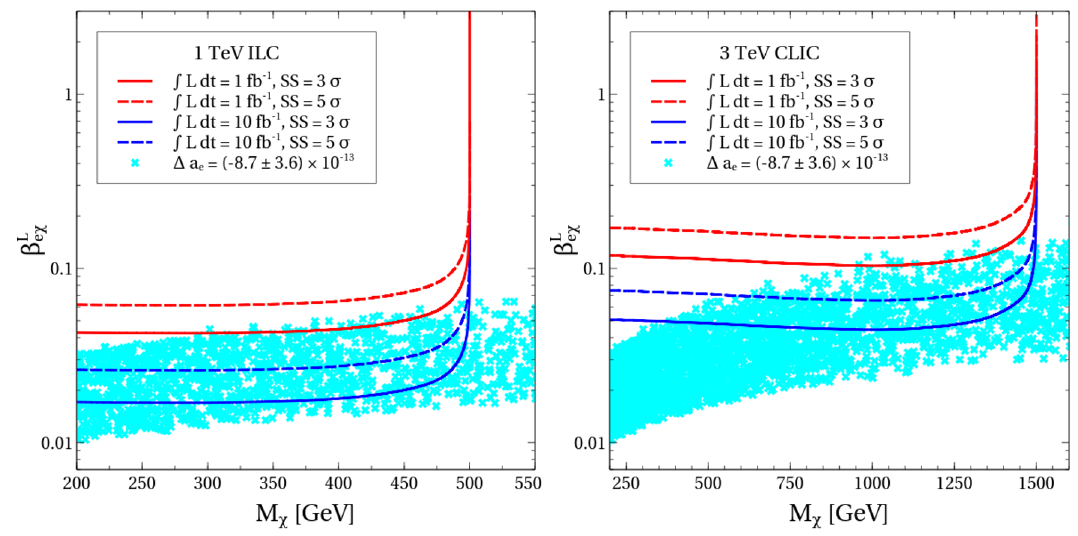
Figure 15 . Left and right panels show the allowed regions (by cyan colour points) after satisfying the ( g − 2) in β L − M χ plane for 1 TeV and 3 TeV lepton colliders, respectively. The solid and e eχ dashed lines correspond to the variation of 3 σ and 5 σ statistical significance lines of e + e − (cid:0) E signal T with the charged singlet fermion mass for the luminosity 1 fb − 1 and 10 fb − 1 , respectively. The other parameters kept fixed at β R = β L , M = 100 MeV, θ = 0 . 1 and M has been varied φ 4 D φ 2 eχ eχ between 1 to 10